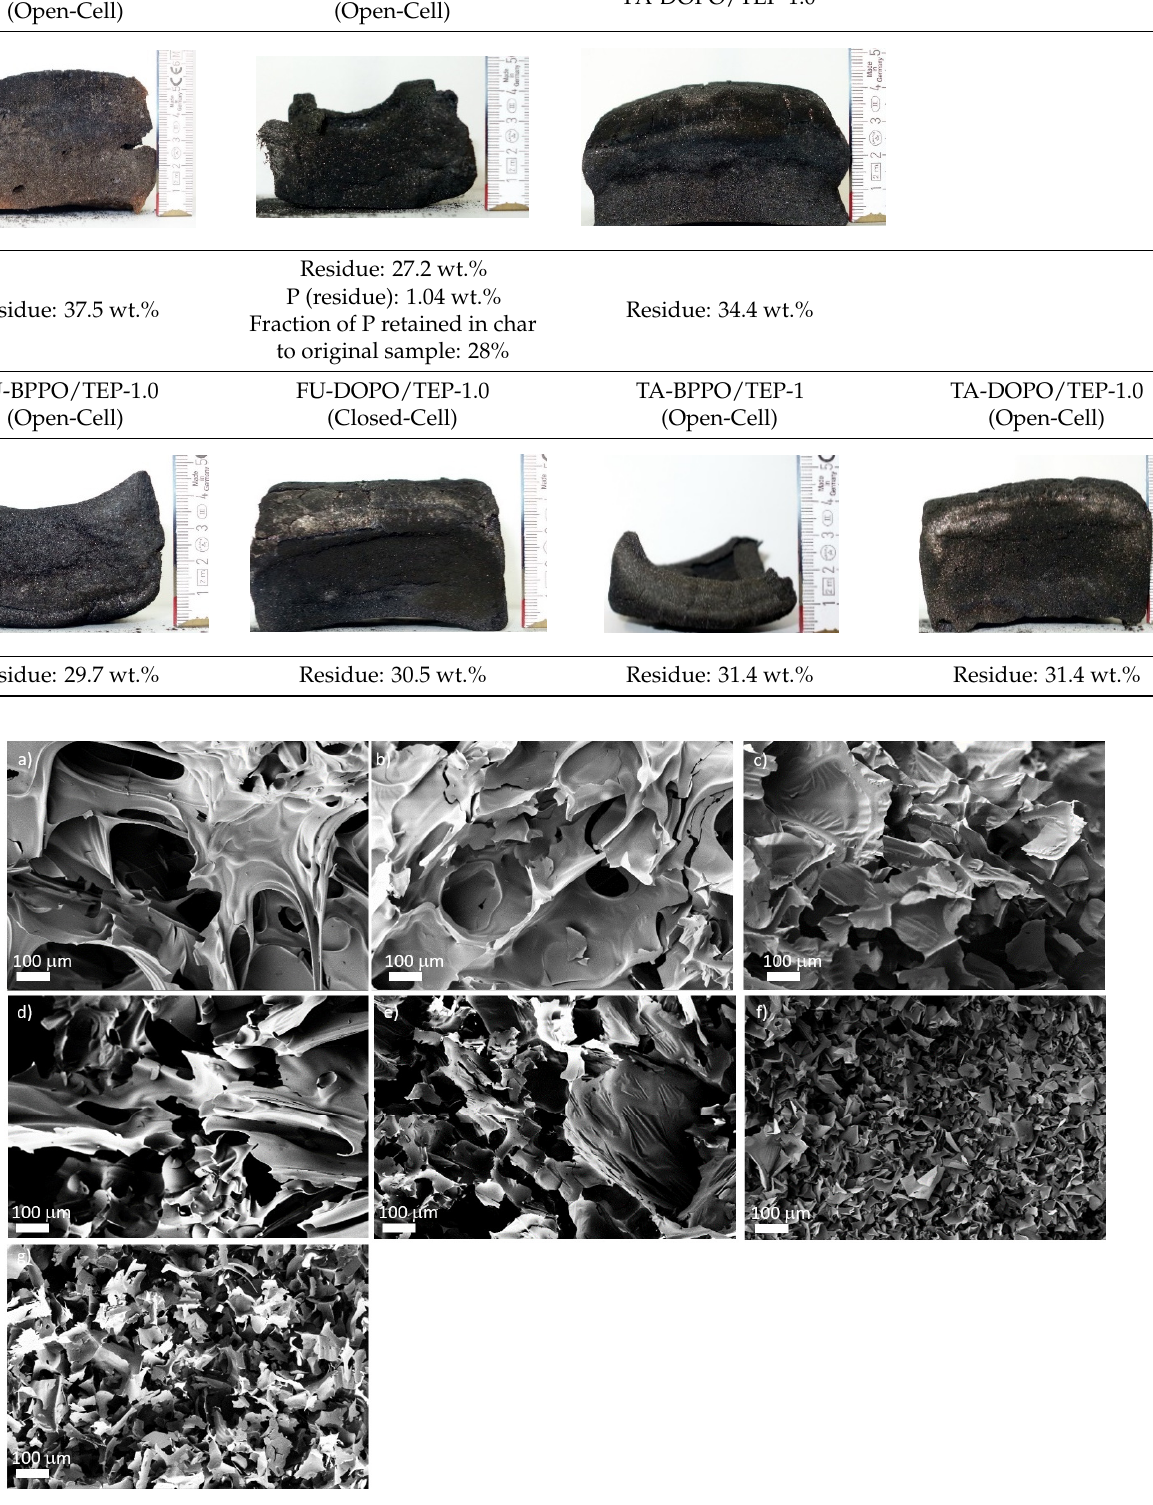
Figure 6. Morphology of the remaining chars after burning of PIR samples with different additives: ( a ) PIR-0; ( b ) TPP/TEP-1.0; ( c ) FA-BP/TEP-1.0; ( d ) FA-BPPO/TEP-1.0; ( e ) FA-DOPO/TEP-1.0; ( f ) BuA-DOPO/TEP-1.0; ( g ) FU-BPPO/TEP-1.0.